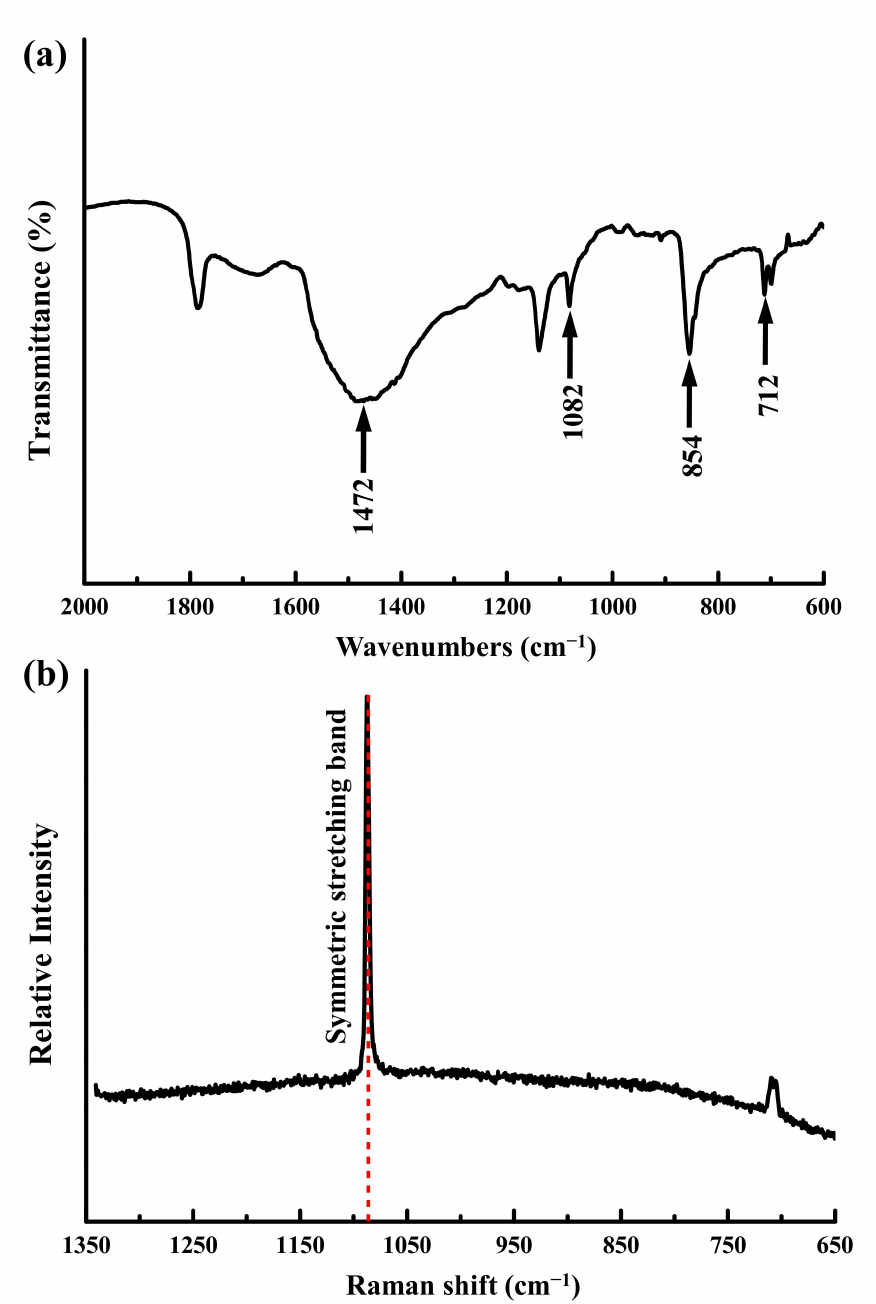
Figure 4. ( a ) FTIR and ( b ) Raman spectra of the as-prepared coral